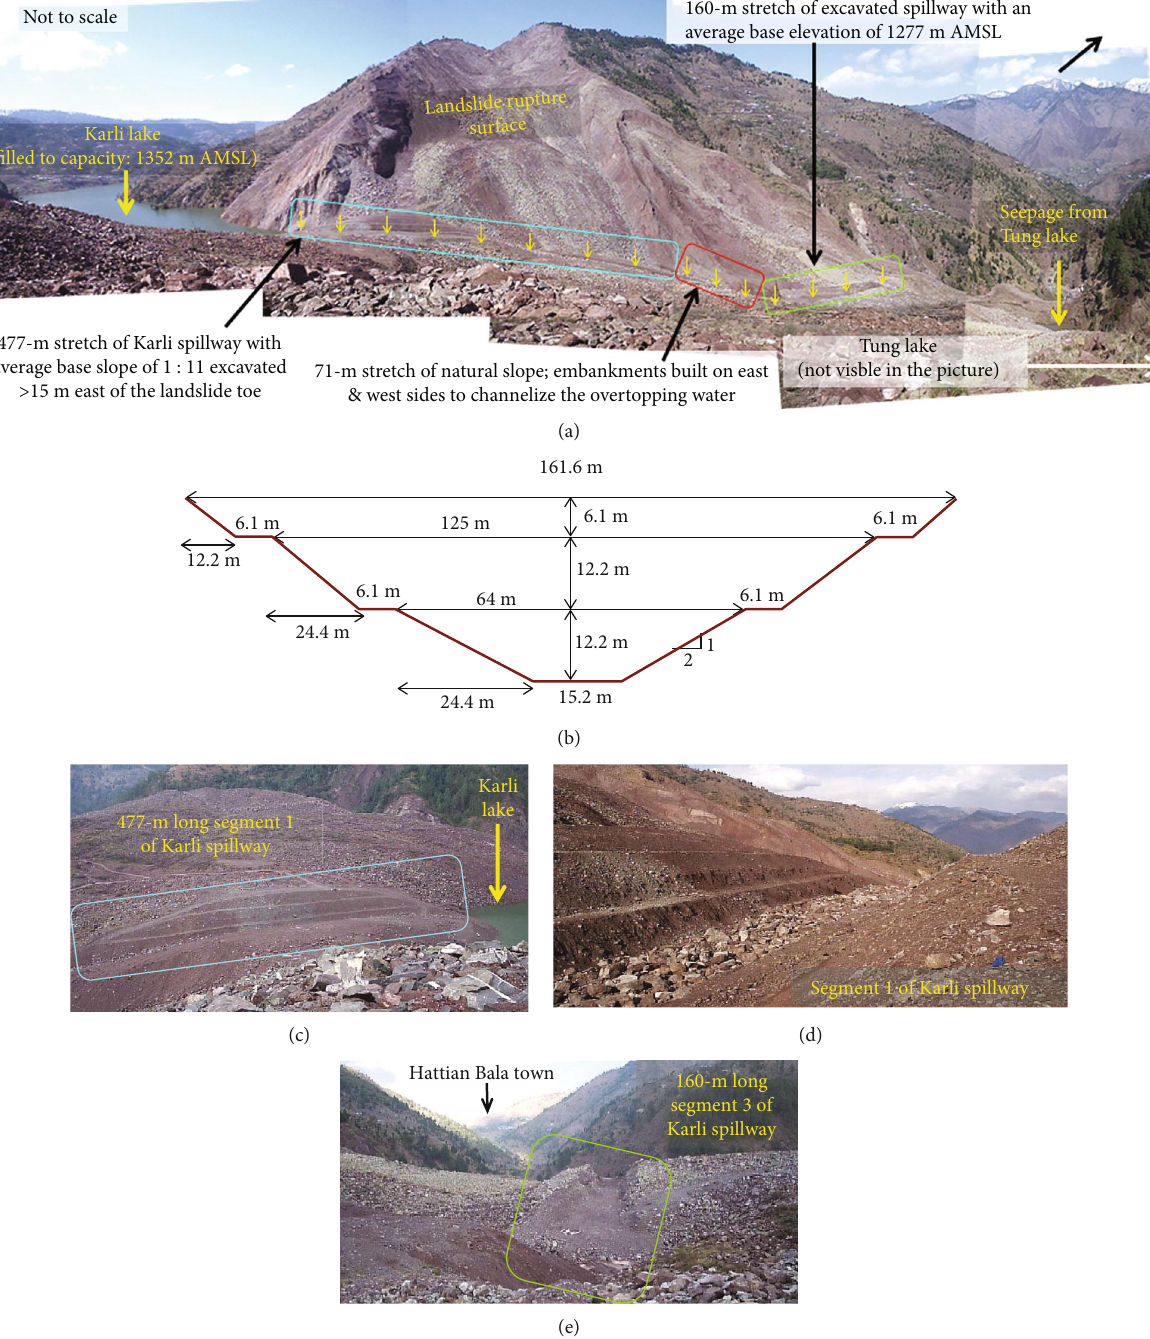
Figure 8: (a) Photomosaic showing complete view of the landslide rupture surface (scarp to toe), Karli lake, landslide dam portion blocking Karli channel, Karli spillway, and Tung lake seepage location (31 March 2007); (b) cross-section of segment 1 of the deepest spillway cut along the landslide dam portion blocking Karli lake; (c) photograph showing a complete view of segment 1 of Karli spillway (May 2006); (d) photograph showing bed treatment of Karli spillway segment 1 (May 2006); (e) photograph showing segment 3 of Karli spillway (December